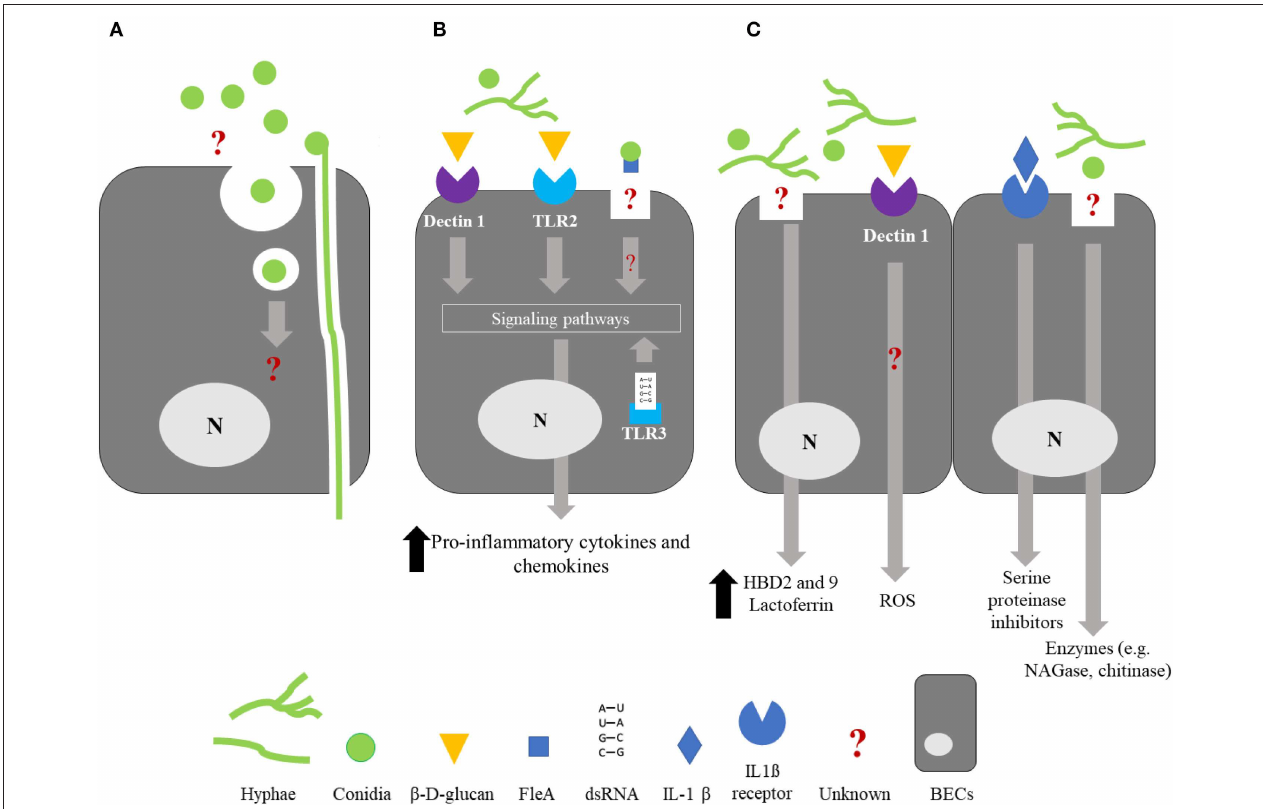
FIGURE 2 | Summary of the interactions between bronchial epithelial cells and Aspergillus fumigatus. For clarity, it should be noted that the schematized epithelial cells are not polarized. (A) Internalization; BECs are able to internalized A. fumigatus conidia but the molecular mechanisms involved in this phenomenon and the fate of the internalized conidia are still unknown. An alternative way of penetration of the hyphae through an actin channel within the cell has been proposed. (B) Cytokine/chemokine release; Recognition of β -D-glucan by BECs through the membrane receptors Dectin-1 and TLR2, and recognition of A. fumigatus dsRNA by the endosomal receptor TLR3 result in the activation of intracellular signaling pathways and a significant increase in the release of proinflammatory cytokines and chemokines, leading to phagocyte recruitment. FleA lectin, expressed on the surface of A. fumigatus conidia, induces IL-8 synthesis by BECs and binding of the conidia to airway mucins. Recognition of FleA by BEC induces the inhibition of conidium germination. (C) Bioactive molecules potentially active against A. fumigatus ; BECs synthetize antimicrobials molecules such as defensins HBD2 and HBD9, lactoferrin, reactive oxygen species (ROS), SLPI, ESI, and chitinase in response to A. fumigatus infection or inflammatory challenge. Until now, an antifungal activity has only been described for lactoferrin, ROS, SLPI, ESI, and chitinase. BECs, Bronchial epithelial cells; SLPI, Secretory leukocyte proteinase inhibitor; ESI, Elastase-specific inhibitor; NAGase, N-Acetyl- β -d-glucosaminidase; ROS, Reactive oxygen species; N,